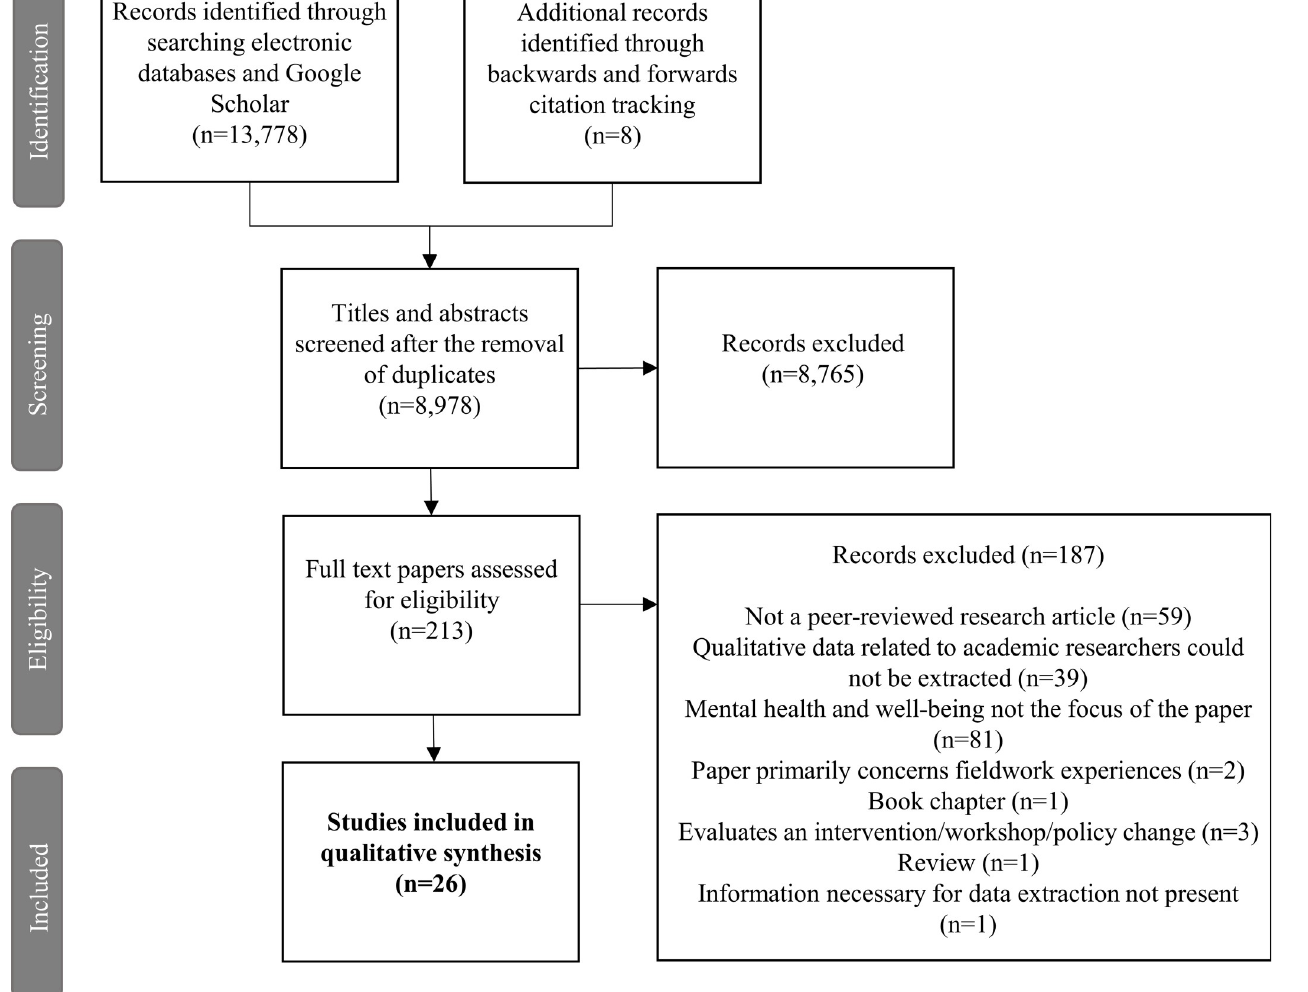
PLOS ONE | https://doi.org/10.1371/journal.pone.0268890 May 25,